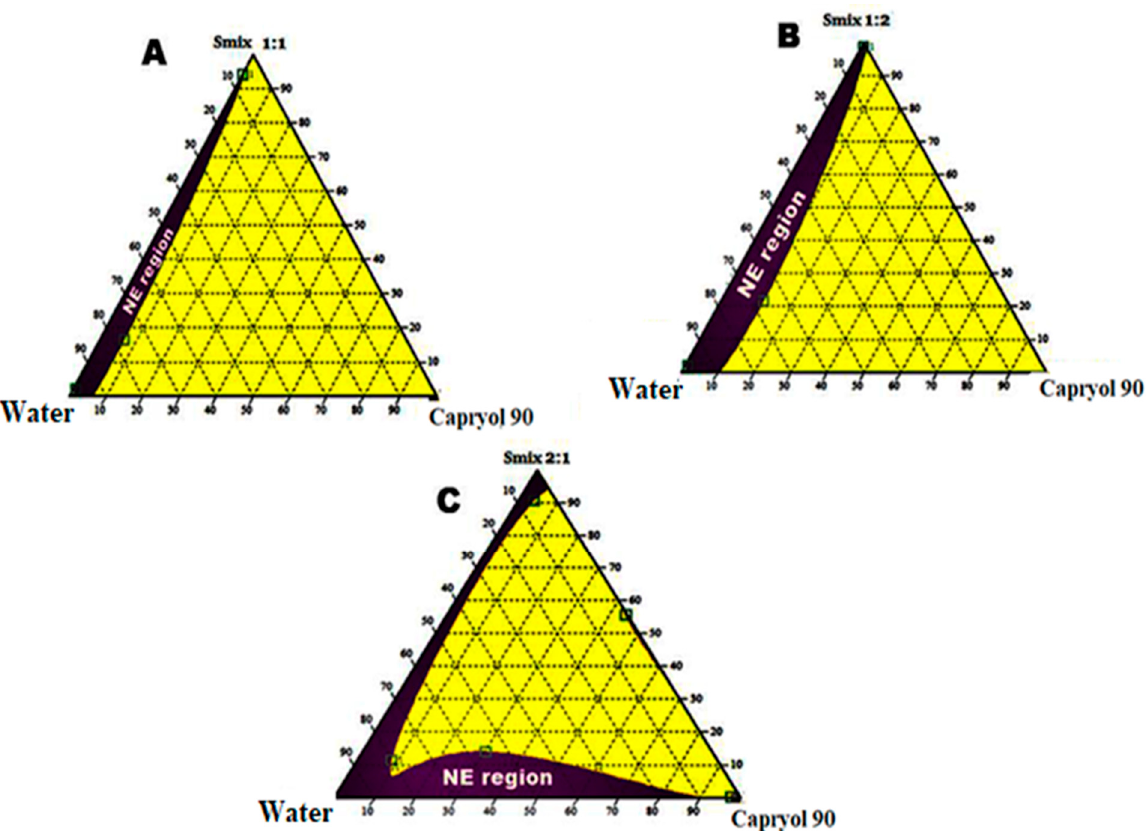
Figure 3. Ternary phase diagram representing the emulsification region. ( A ) With Smix ratio = 1:1, ( B ) Smix ratio = 1:2, & ( C ) Smix ratio = 2:1. purple colored area indicates nanoemulsion and yellow colored area indicates microemulsion. Table 1. Different formulation mixtures with varying concentrations of oil, surfactant, and co-surfactant. Table 2. Transmittance (%), saturation solubility, and cloud point of polymeric SNEDDS. The results are listed as mean ± S.D (n = 3). Formulations CIP-Loaded